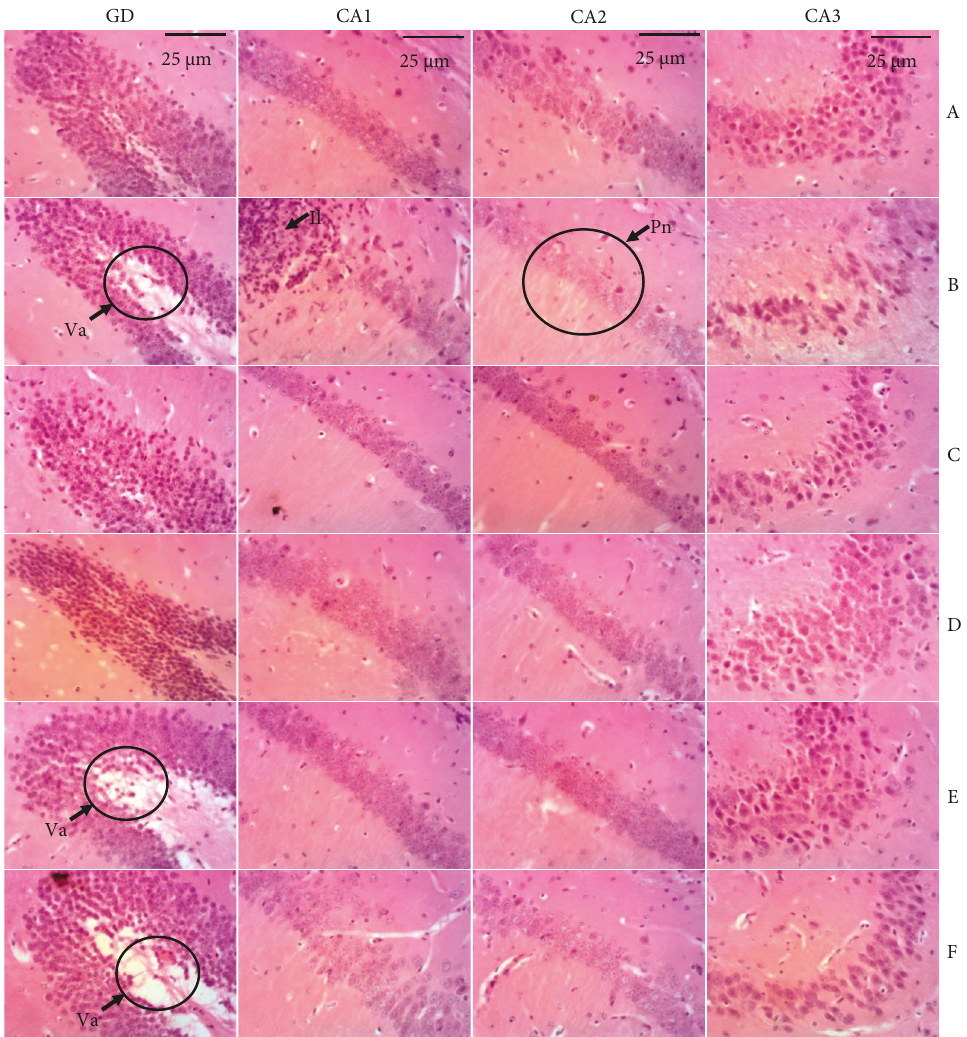
SEM; n 5. DZP diazepam, PIR piracetam, Cc Crassocephalum crepidioides . (cid:31) (cid:31) (cid:31) (cid:31) ±